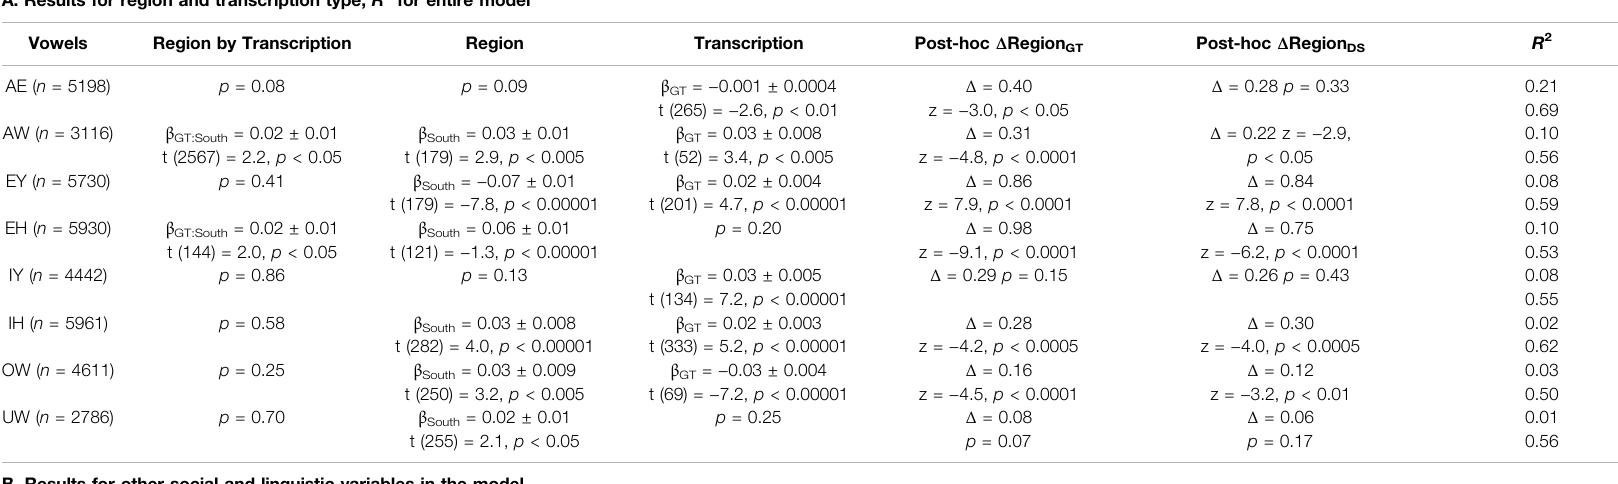
TABLE 2 | LMER models for comparison between Southern Vowel Shift (SVS) and General North vowels. The dependent variable is F2 for the vowels MOUTH (AW), GOAT (OW), GOOSE (UW), and F2-2xF1 for the vowels TRAP (AE), FACE (EY), DRESS (EH), FLEECE (IY),and KIT (IH). R 2 showsmarginalandconditional coef fi cient.Deltasshowthedifference betweenthemeanpositionoftheNorthernvowelandthemeanpositionoftheSouthernvowel for each transcription type: AE shows divergence in GT/DS results; for the other vowels, either both models detect a North/South difference or they do not. A. Results for region and transcription type; R 2 for entire